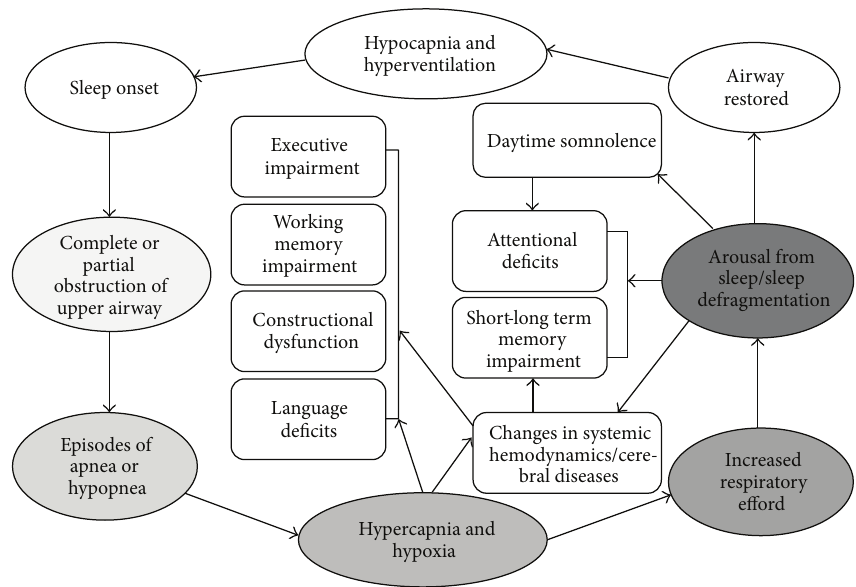
Figure 2: The possible minimal mechanism that causes cognitive deficits in OSAS